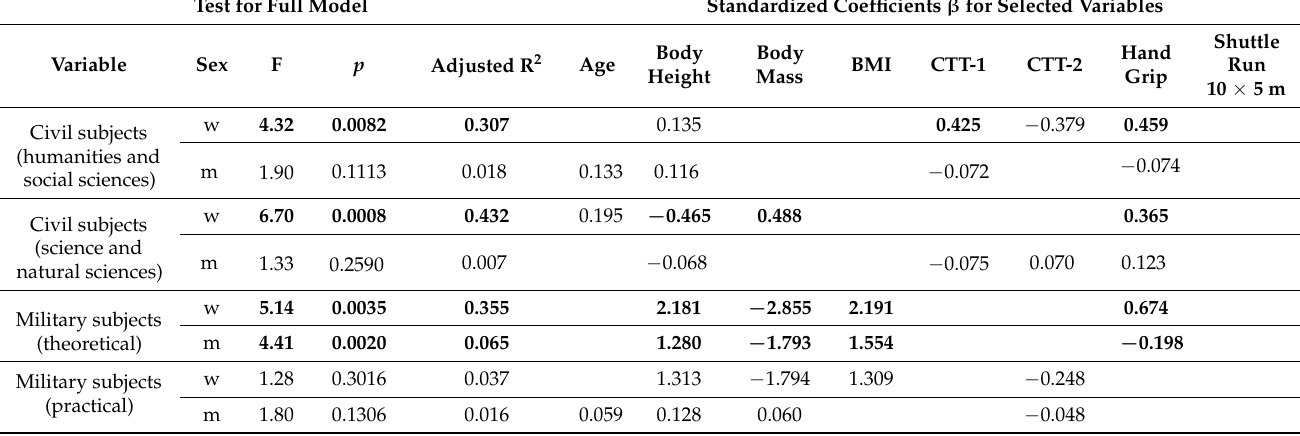
Table 4. Results of regression analysis (using the best in terms of adjusted R 2 4-element subset method) of AA of men and women as a function of their morpho-functional development and level of attention. Standardized Coefficients β highlighted in bold are significant with p <